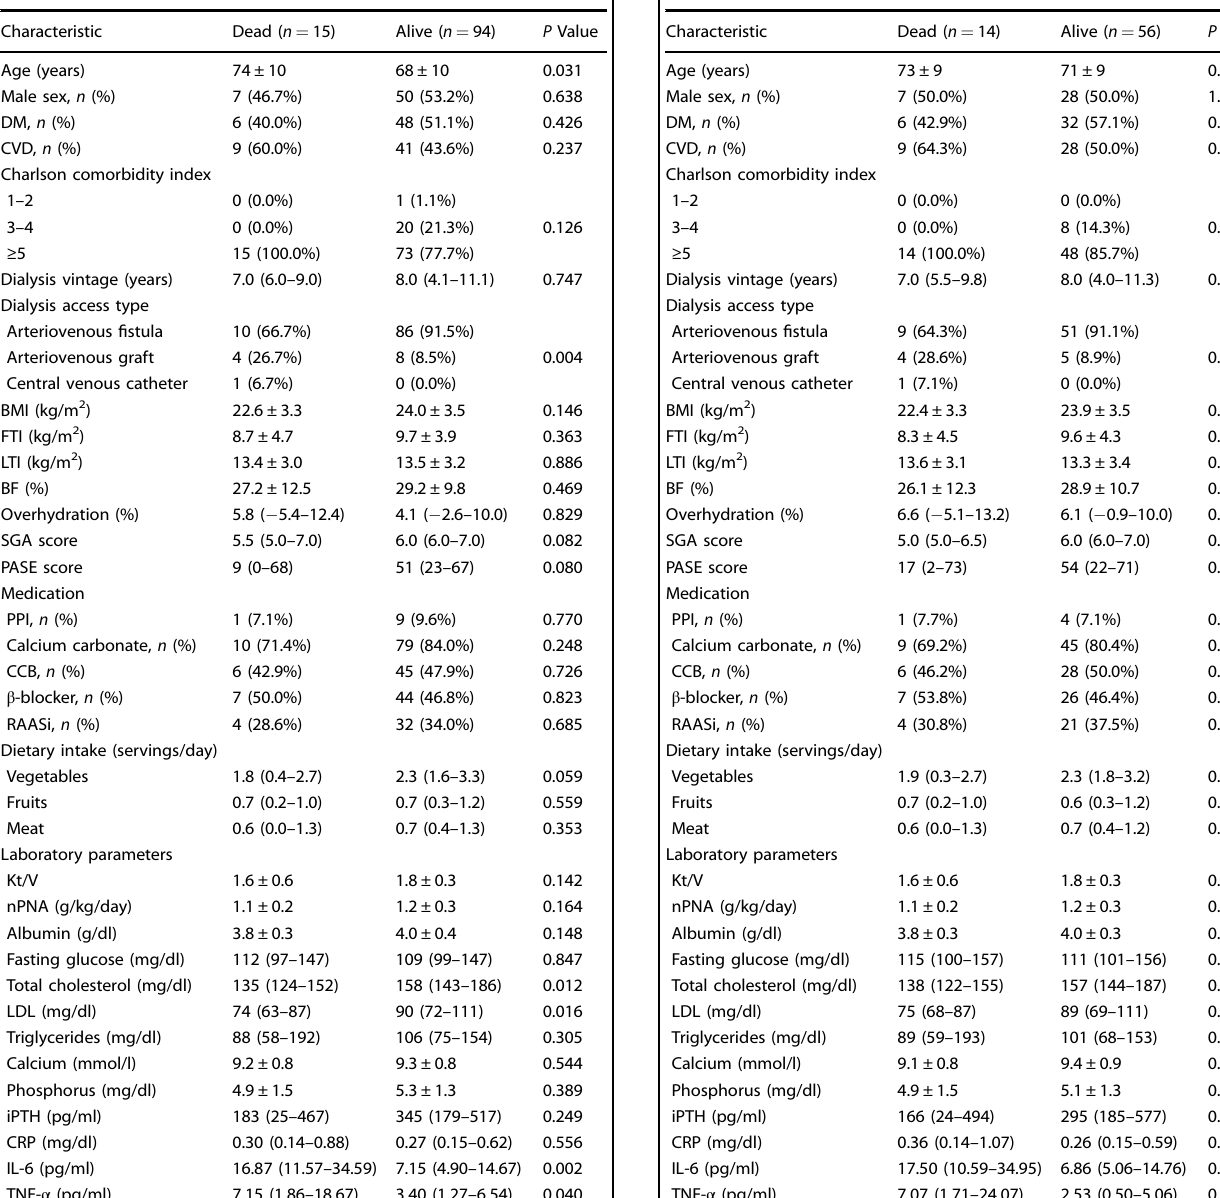
Table 3. Baseline characteristics of patients according to mortality status before matching.